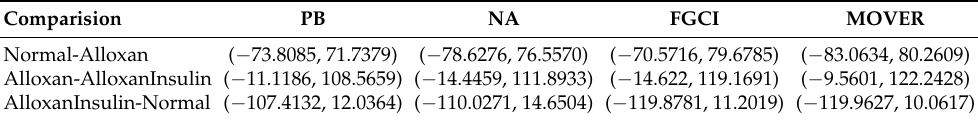
Figure 2. Histogram and PDF fit of bovine serum albumin in three groups of diabetic mice. The 95% confidence intervals and corresponding lengths for the differences of the pairwise comparisons for the treated groups and control group based on the PB, NA, FGCI and MOVER methods are summarized in Tables 9 and 10. Table 9. The 95% confidence intervals for the differences of the medians for 3 groups.